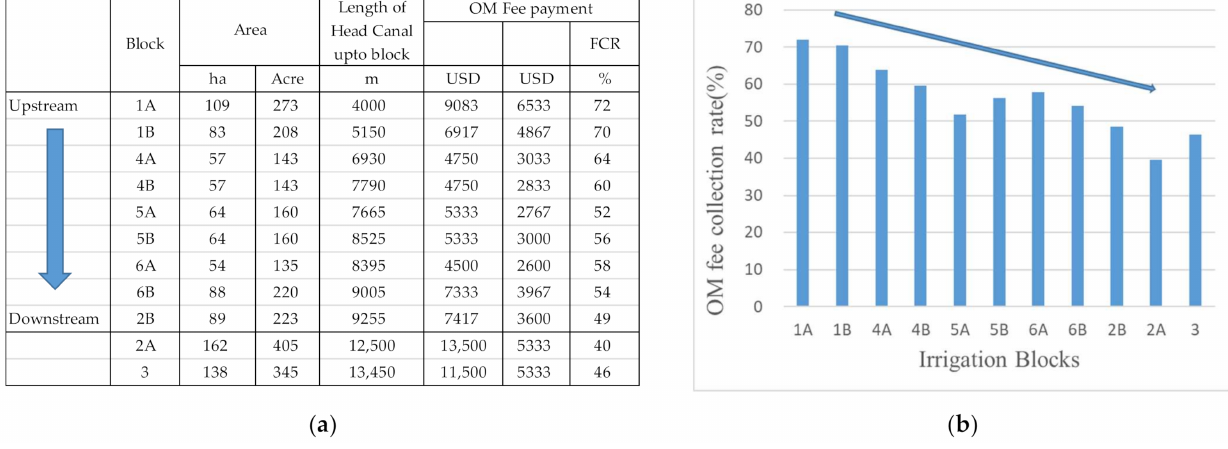
Figure 5. FCR among irrigation blocks ( a ) and FCR variation among irrigation blocks ( b ).